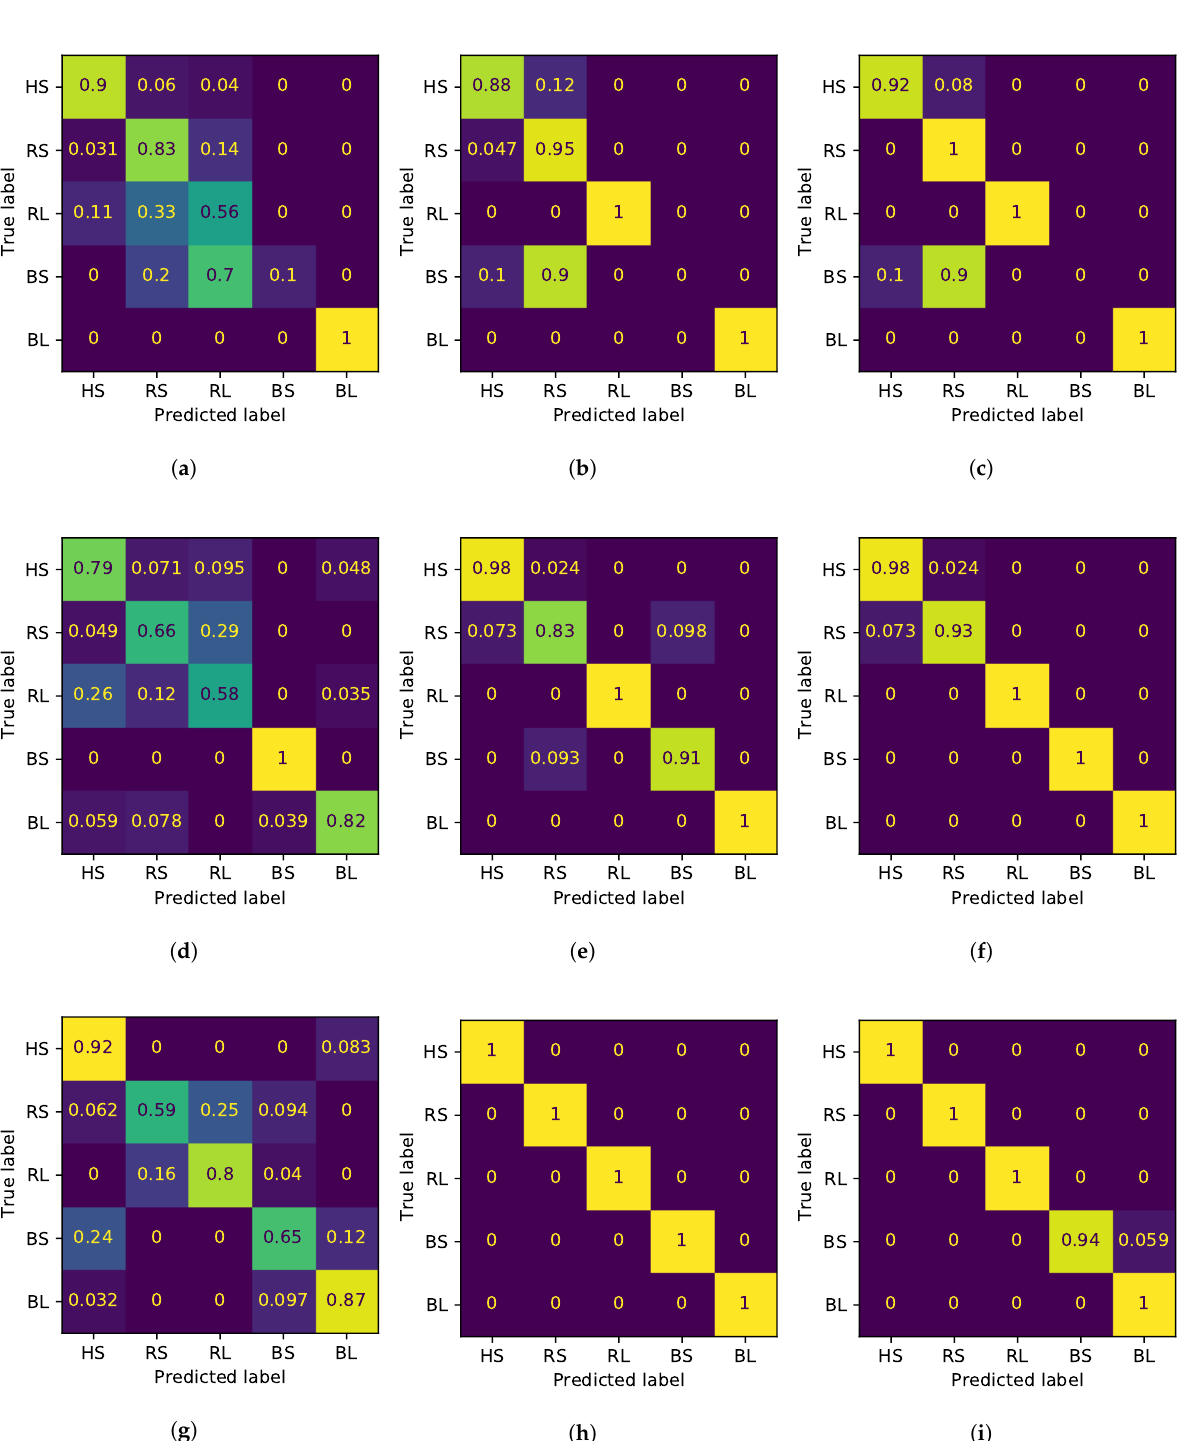
Predicted label